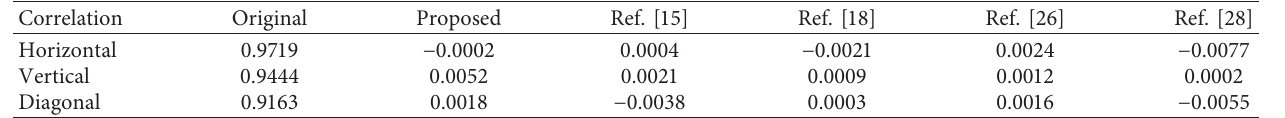
Figure 11: Correlation of adjacent pixels in plaintext and encrypted images. Table 3: Correlation of adjacent pixels in plaintext and encrypted images.